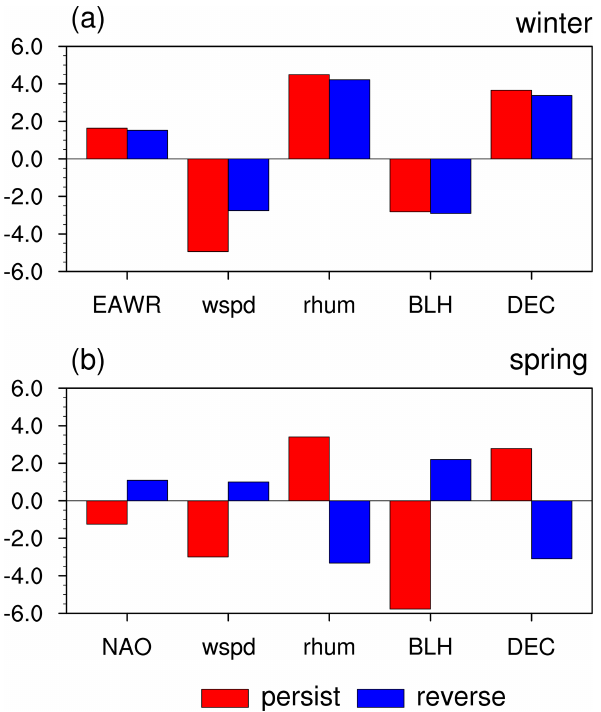
Figure 9. (a) Composite anomalies of the EAWR index, wind speed (“wspd”) at 850hPa (4 − 1 ms − 1 ), relative humidity (“rhum”) at 850hPa (%), BLH (10 1 m), and DECC (“DEC”) (10 − 2 km − 1 ) aver- aged over the NCPR in winter for the persistent years (red bars) and the reverse years (blue bars). (b) Composite anomalies of the NAO index, wind speed at 850hPa (ms − 1 ), relative humidity at 850hPa (%), BLH (10 1 m), and DECC (km − 1 ) averaged over the NCPR in spring for the persistent years (red bars) and the reverse years (blue